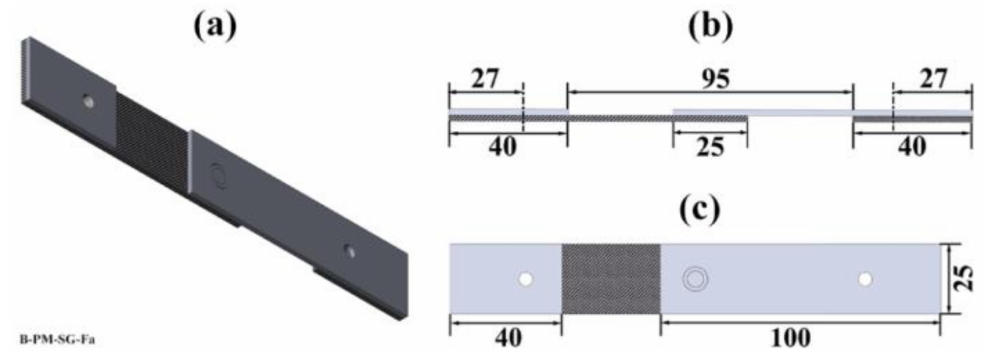
Figure 2. ( a ) Schematic illustration of the geometry of the fatigue specimen; the respective dimensions used in this work from ( b ) the side view and ( c ) the top view. All dimensions are in millimeters. Reprinted from [7] with permission; Copyright Springer Nature